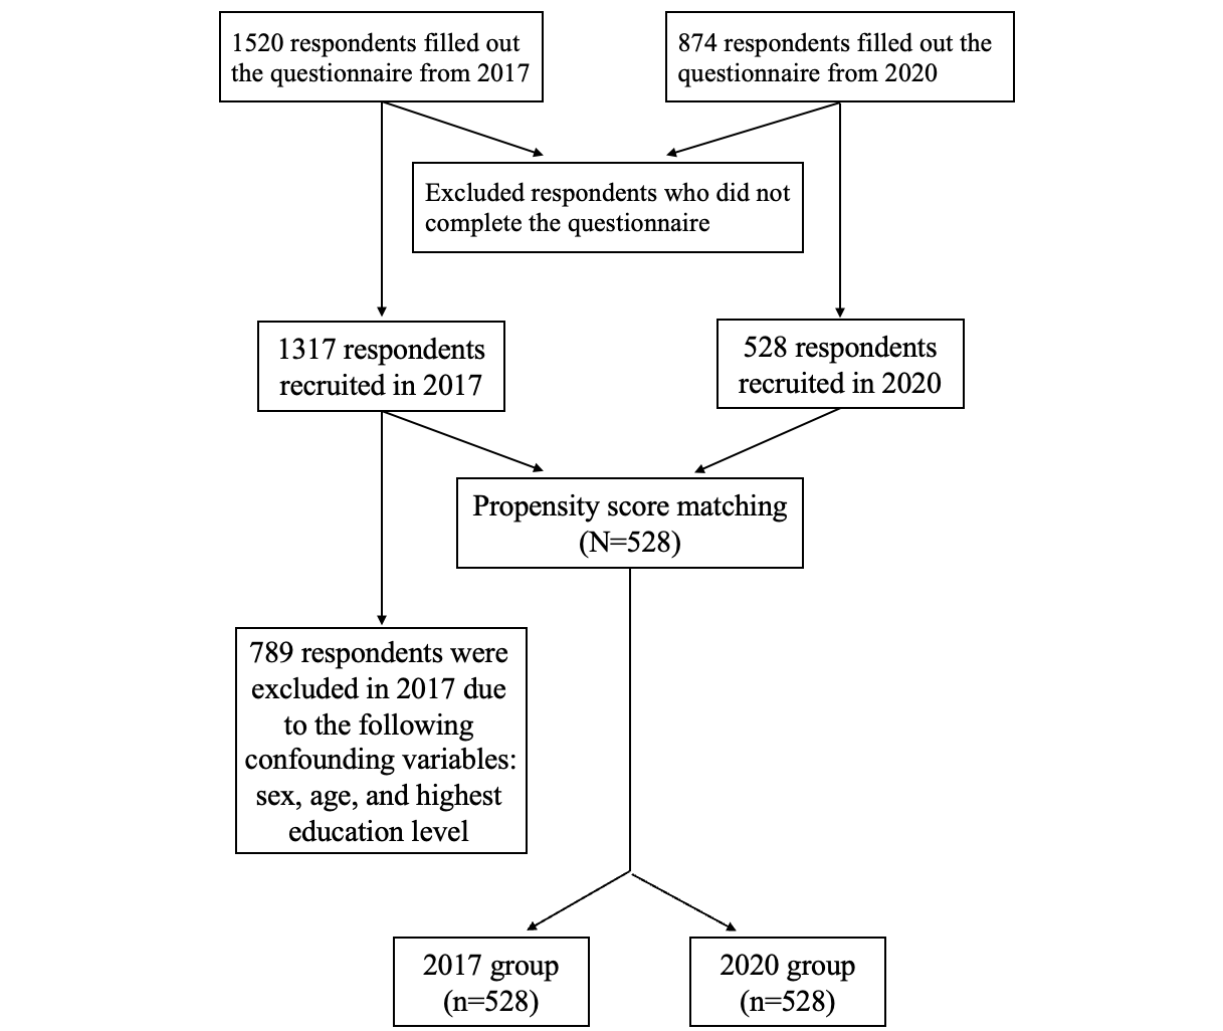
Figure 1. Propensity score matching procedure.